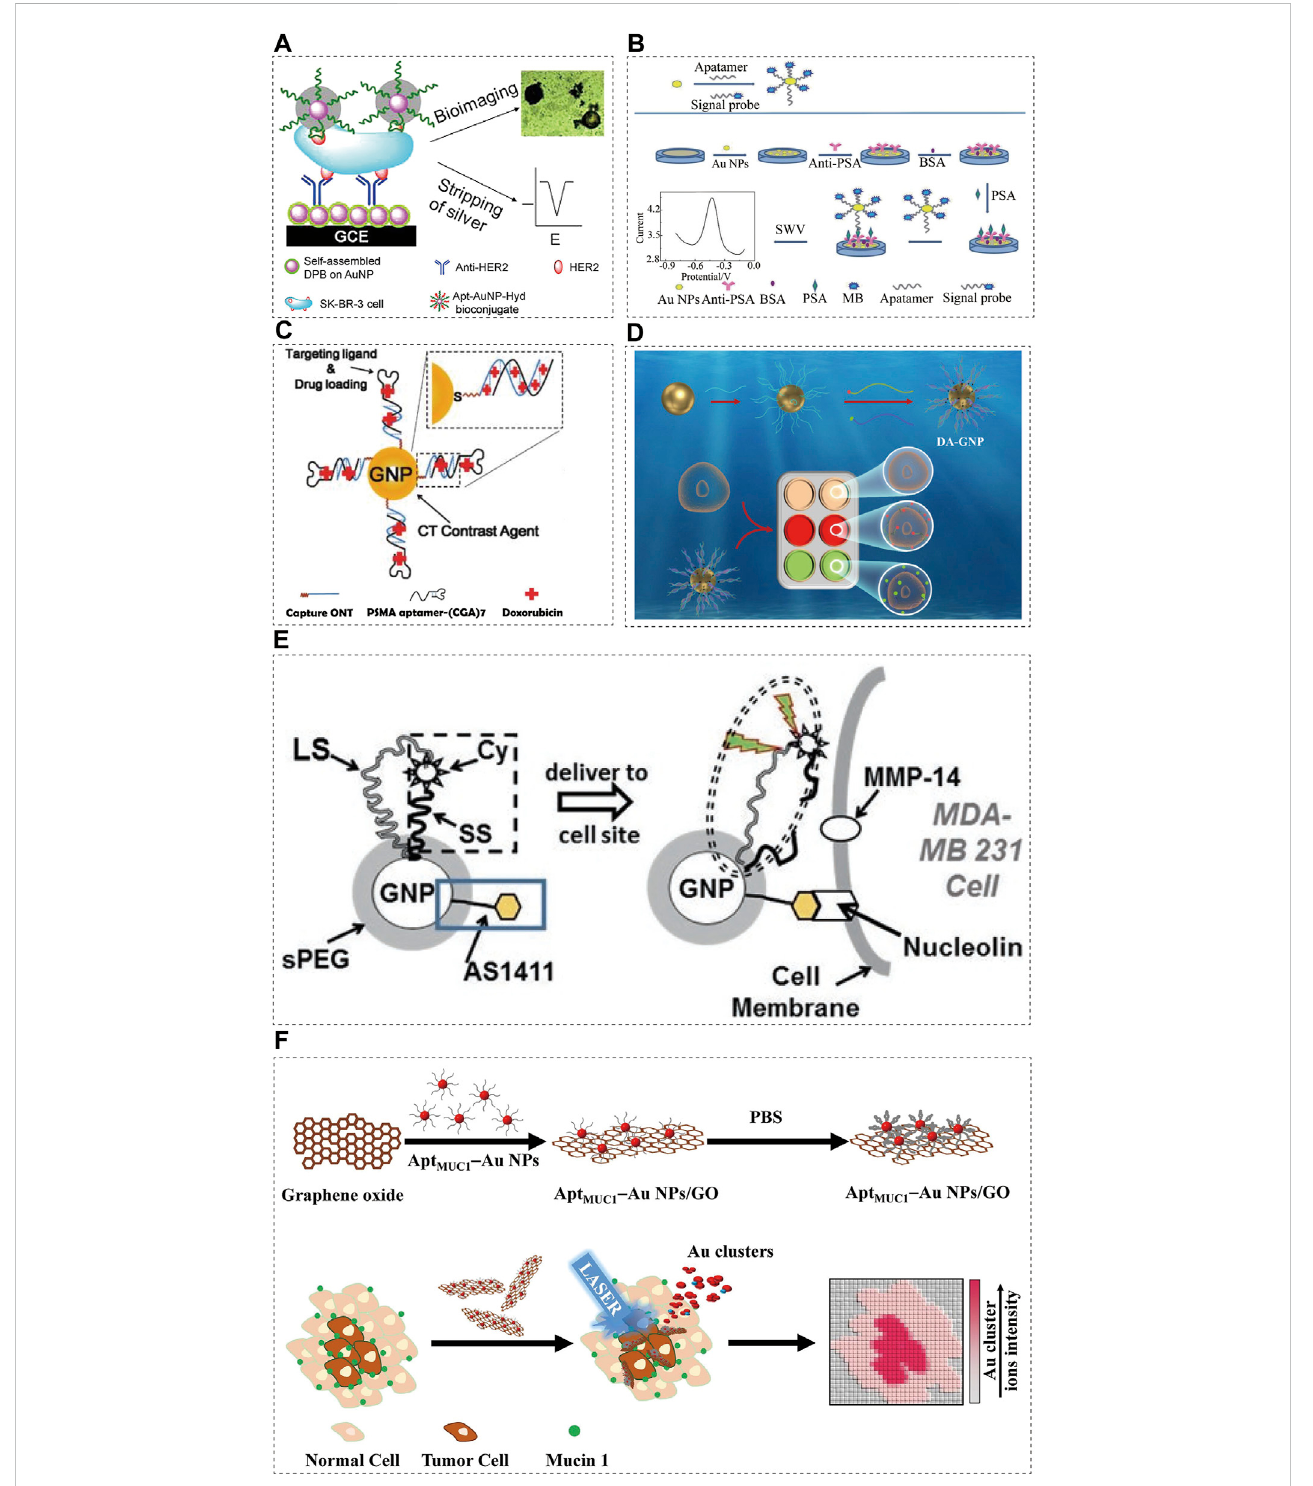
FIGURE 2 Aptamer-conjugatedAuNPsincancerdiagnostics.Schematicillustrationsshowing: (A) Schematicrepresentationofimmunosensorsforthedetectionof HER2 protein and HER2-overexpresing SK-BR-3 breast cancer cells, reprinted with permission from (Zhu et al., 2013), Copyright 2013, American Chemical Society; (B) Assembly and detection process of the immunosensor, reprinted with permission from (Li M et al., 2021), Copyright 2022, American Chemical Society; (C) Schematic illustration of the method for preparing Dox-loaded aptamer-conjugated AuNPs (Kim et al., 2010), Copyright 2010, ACS Publications; (D) Illustration of classi fi cation of breast cancer by DA-GNP, aptamer-conjugated AuNPs (Wu et al., 2022), Copyright 2022, Elsevier; (E) Schematic diagram of AuNP-based optical/CT contrast agent for MDA-MB 231, aptamer-conjugated AuNPs (Kang and Nguyen, 2017), Copyright 2017, Spinger eBook; (F) Schematic representation of the preparation of MUC1-binding aptamer – modi fi ed AuNPs (AptMUC1 – Au NPs) and their conjugation to graphene oxide (AptMUC1 – Au NPs/GO) for tumour tissue imaging by monitoring Au cluster ions when coupled with laser desorption/ionization mass spectrometry, aptamer-conjugated AuNPs (Huang et al., 2015), Copyright 2015, Spinger